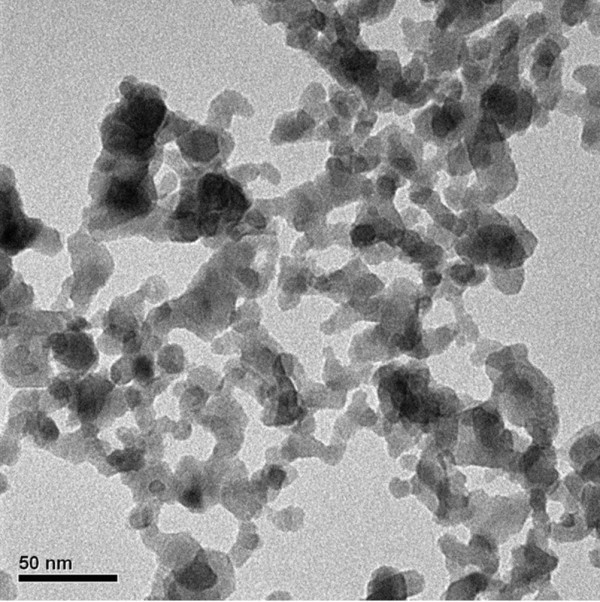
TEM images of Al2O3 nanoparticles.